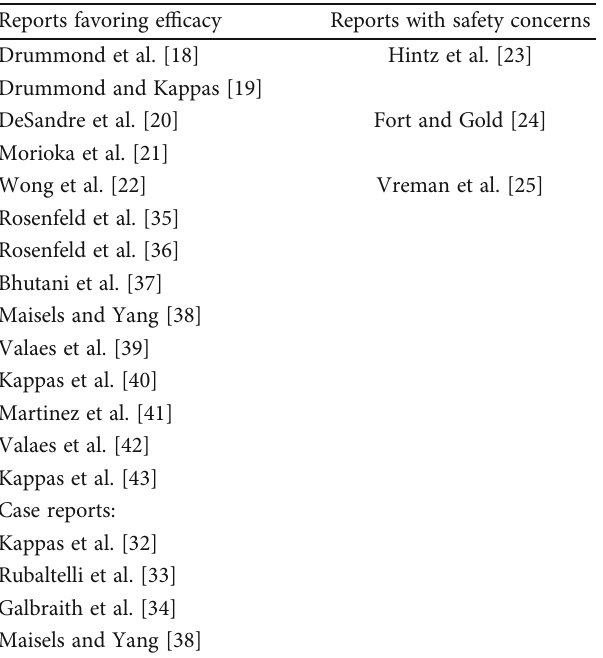
Table 1: Reports for and against Sn-mesoporphyrin in neonatal